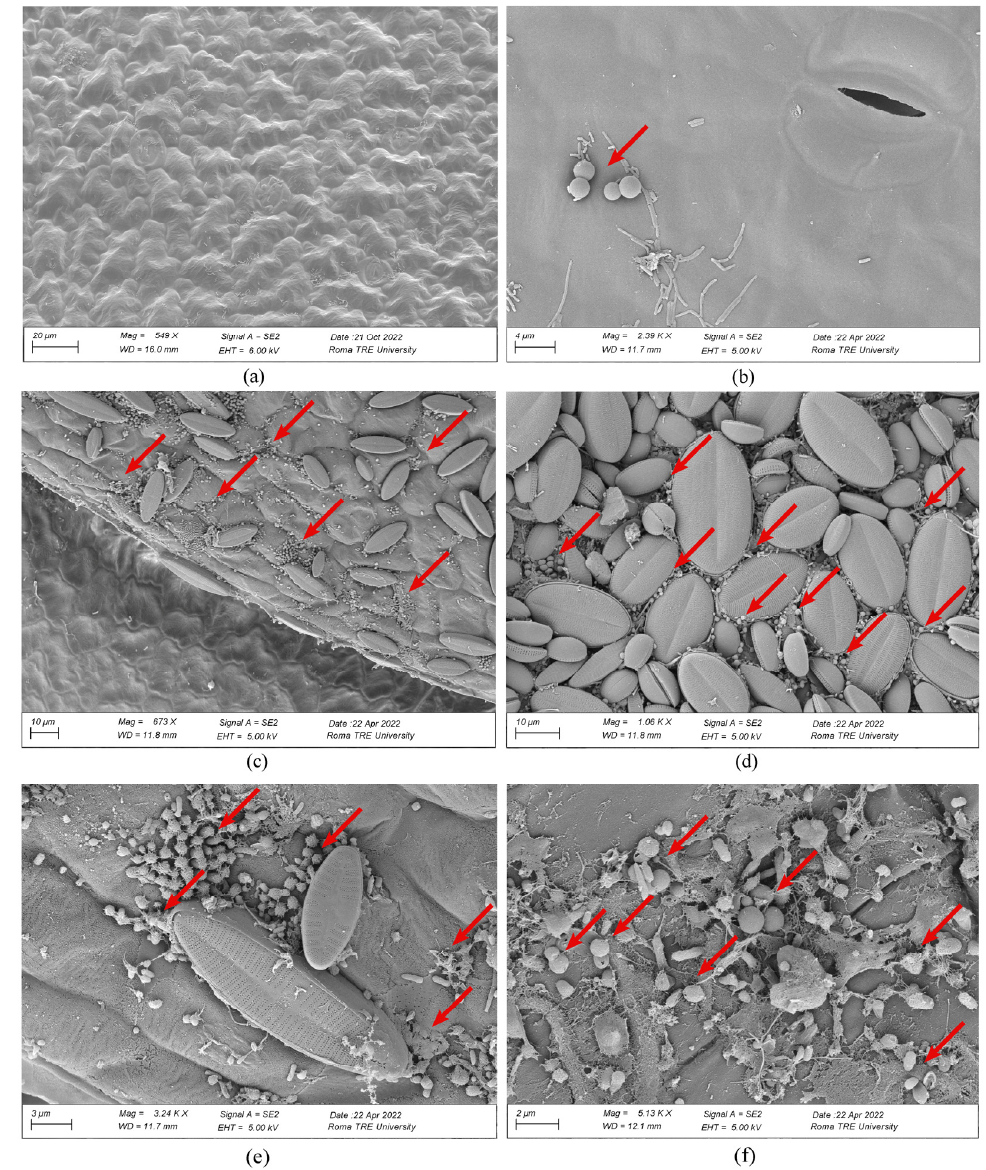
Figure 5. Scanning Electron Microscopy (SEM) images of L. minuta fronds grown in aqueous medium without ( a ) and with MP particles (arrows) ( b – f ). In detail: adaxial frond surface in control test at T28 ( a ), MP microspheres adsorbed onto the adaxial surface in PS50 treatment at T7 ( b ), and on abaxial surfaces in PS50 at T7 ( c ), in PS50 at T28 ( d ), and in PS100 at T28 ( e – f ). Evident aggregates of MPs with pennate diatoms ( c – e ).